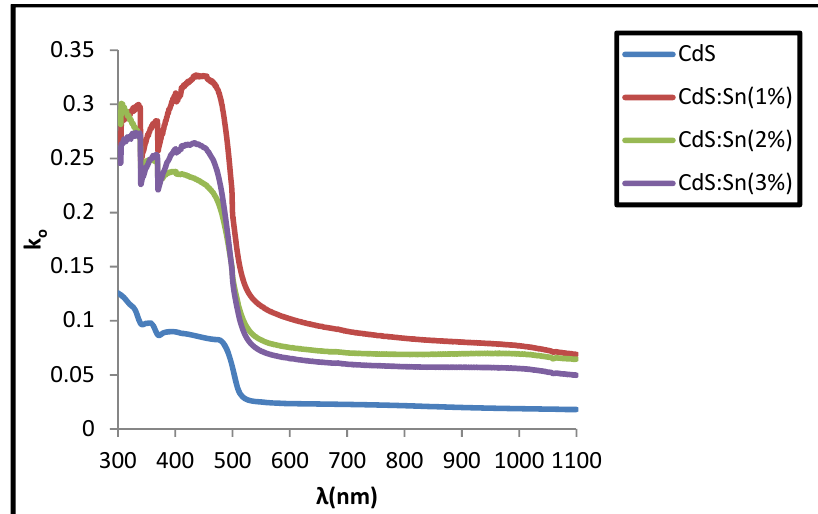
Fig. 7: Extinction coefficient as a function of wavelength for CdS and CdS:Sn thin film